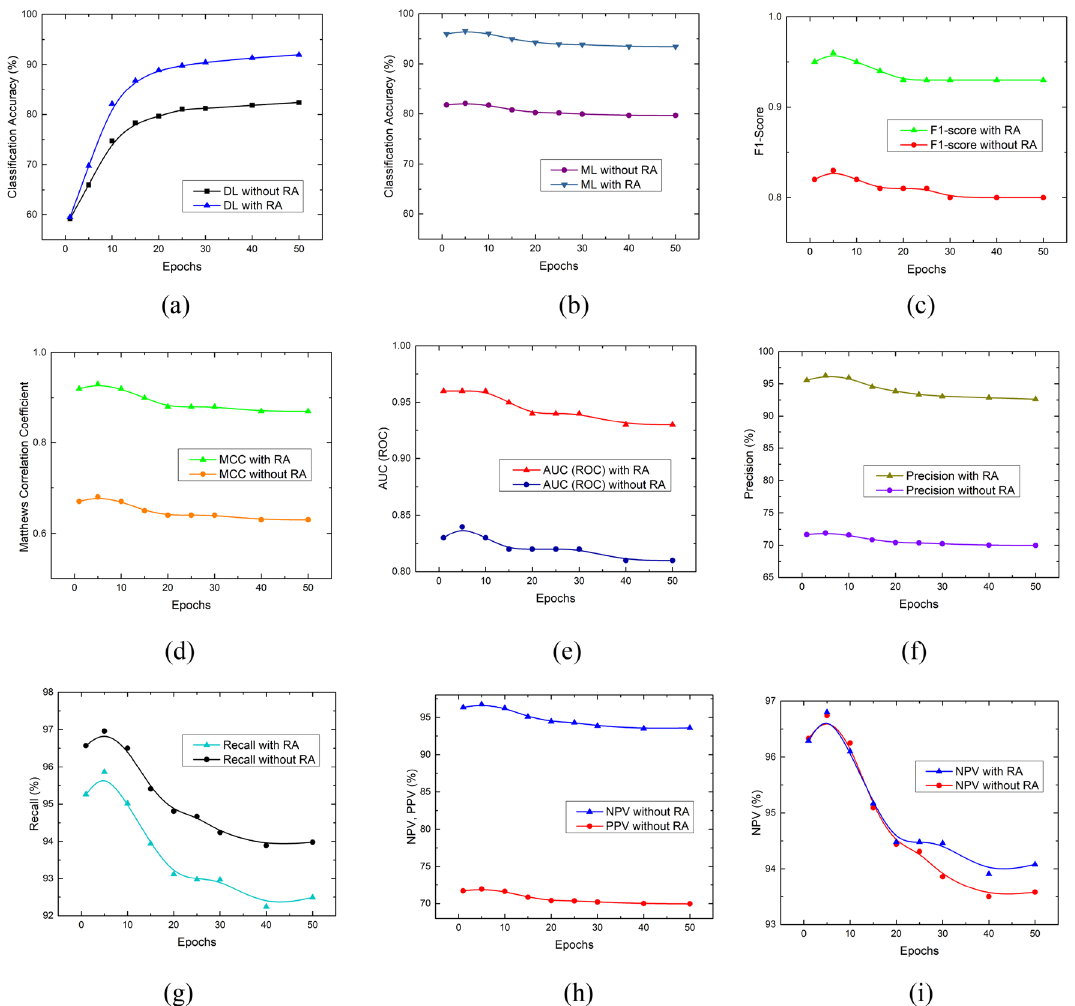
Figure 10. Performance analysis of RA for BraTS-2021 dataset based on: ( a ) accuracy variation with DL with softmax used as the classifier, ( b ) accuracy variation using k -NN model ML with x -axis showing the epochs used to retrieve the x latent ( c ) F 1 -score plot, ( d ) MCC plot, ( e ) AUC (ROC) variation with epochs, ( f ) precision variation with epochs, ( g ) recall variation with epochs, ( h ) PPV and NPV plots for varying epochs without RA, ( i ) NPV with and without RA plots.